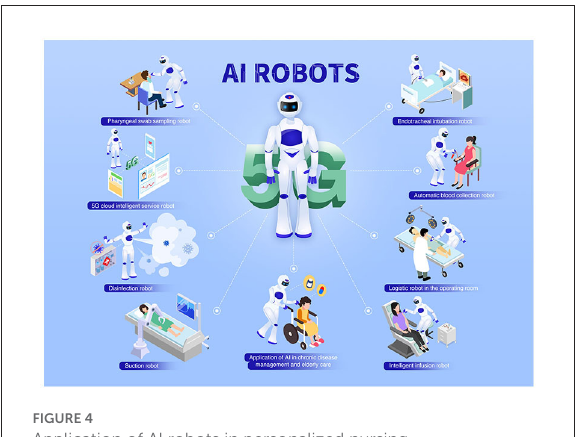
FIGURE4 Application of AI robots in personalized